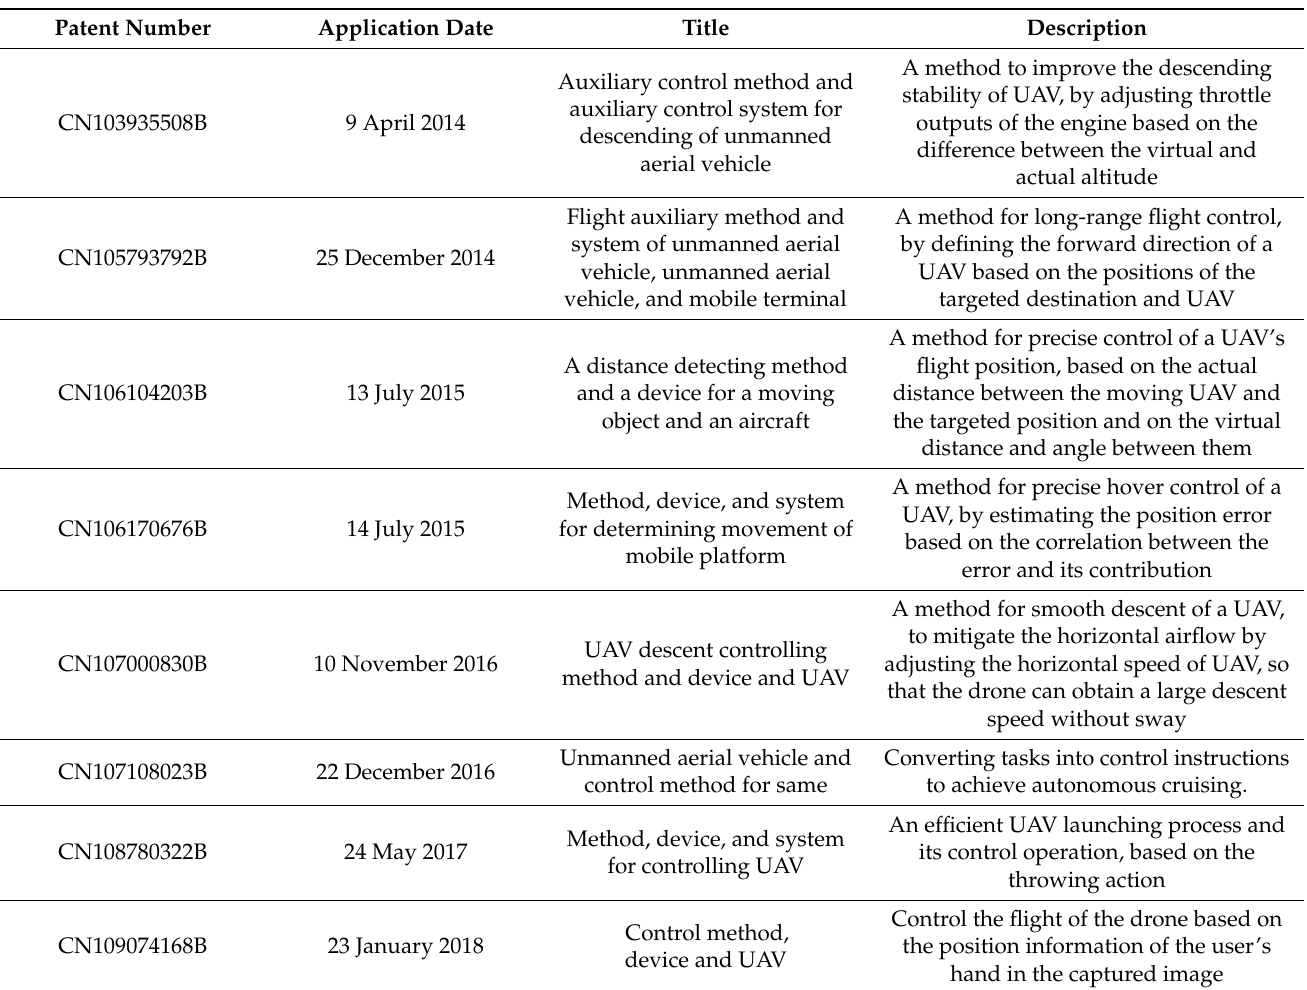
Table 5. Patents with radical invention features for the control system of